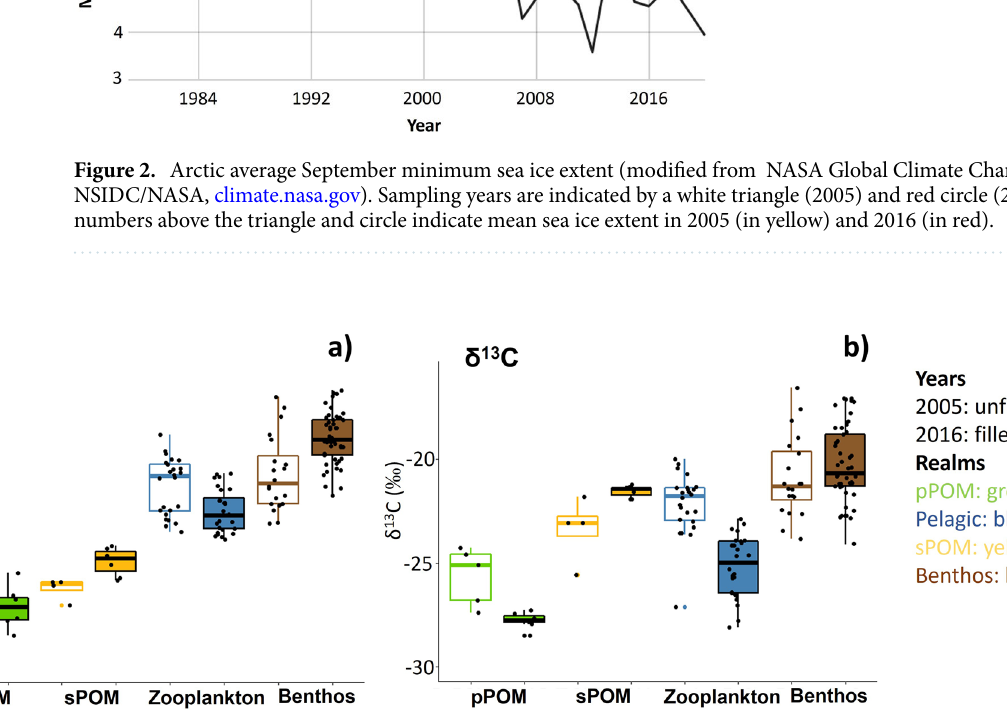
Figure 3. Mean values of ( a ) δ 15 N and ( b ) δ 13 C (‰) per food web component (pPOM in green, pelagic in blue, sPOM in yellow, and benthos in brown) in 2005 (open boxplots) and 2016 (filled boxplots), collected in the Chukchi Borderland. pPOM and sPOM is pelagic and sediment particulate organic matter, respectively. Only comparable taxa were included (i.e., either the same or closely related taxa).